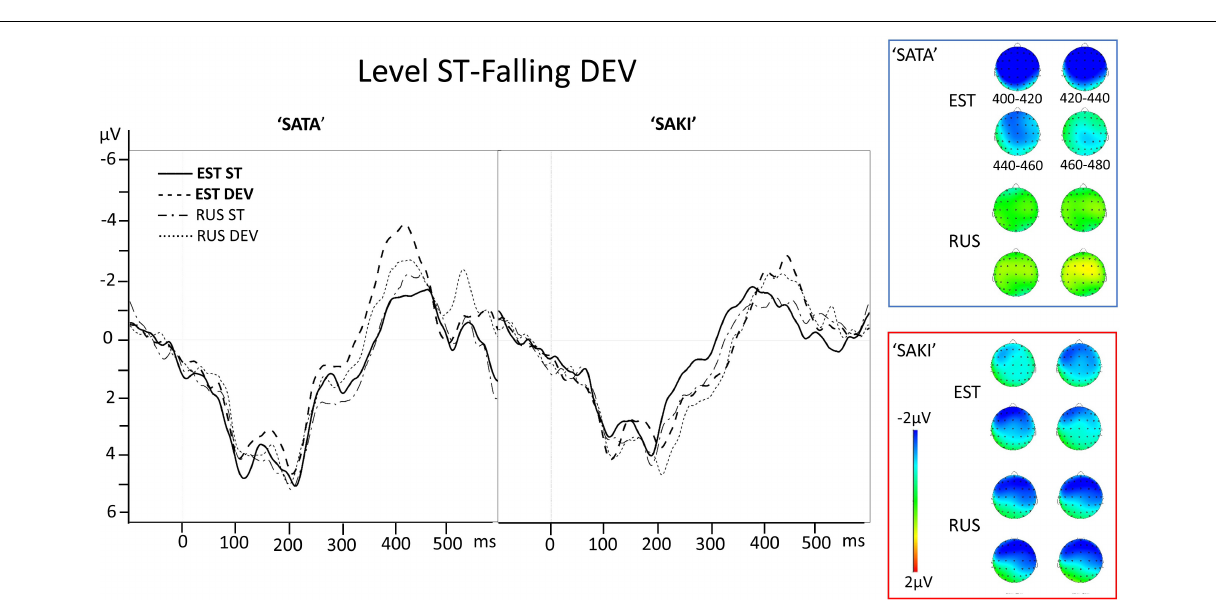
FIGURE 4 | Electrode AF3 averaged ERP activity for standard (ST) and deviant (DEV) stimuli in ‘Level ST-Falling DEV’ comparisons for ‘SATA’ and ‘SAKI’ stimuli in Estonian (EST) and Russian (RUS) Language groups. Right panel represents distribution of the averaged mismatch response (DEV-ST) in 400–480 ms. Please observe, that first 83–100 ms are exactly the same for ST and DEV under comparison (consonant, see stimuli in Figure 1